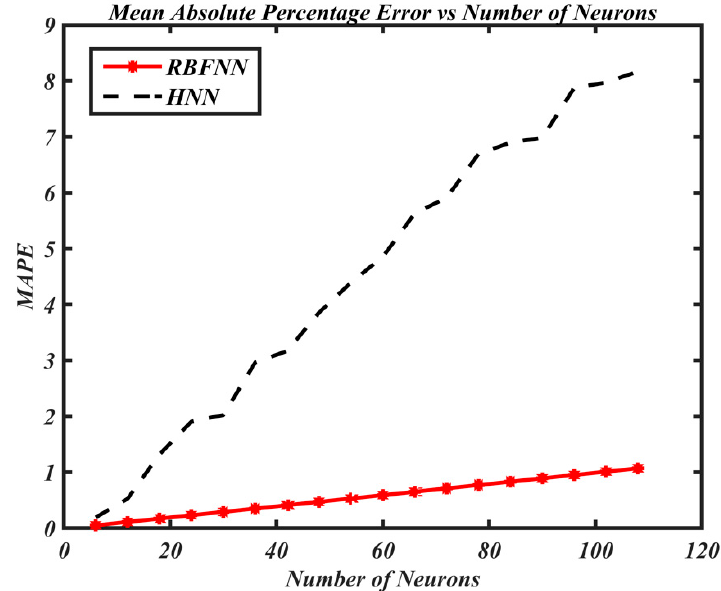
Figure 5. The performance of proposed RBFNN and HNN in term of Mean Absolute Percentage Error (MAPE).